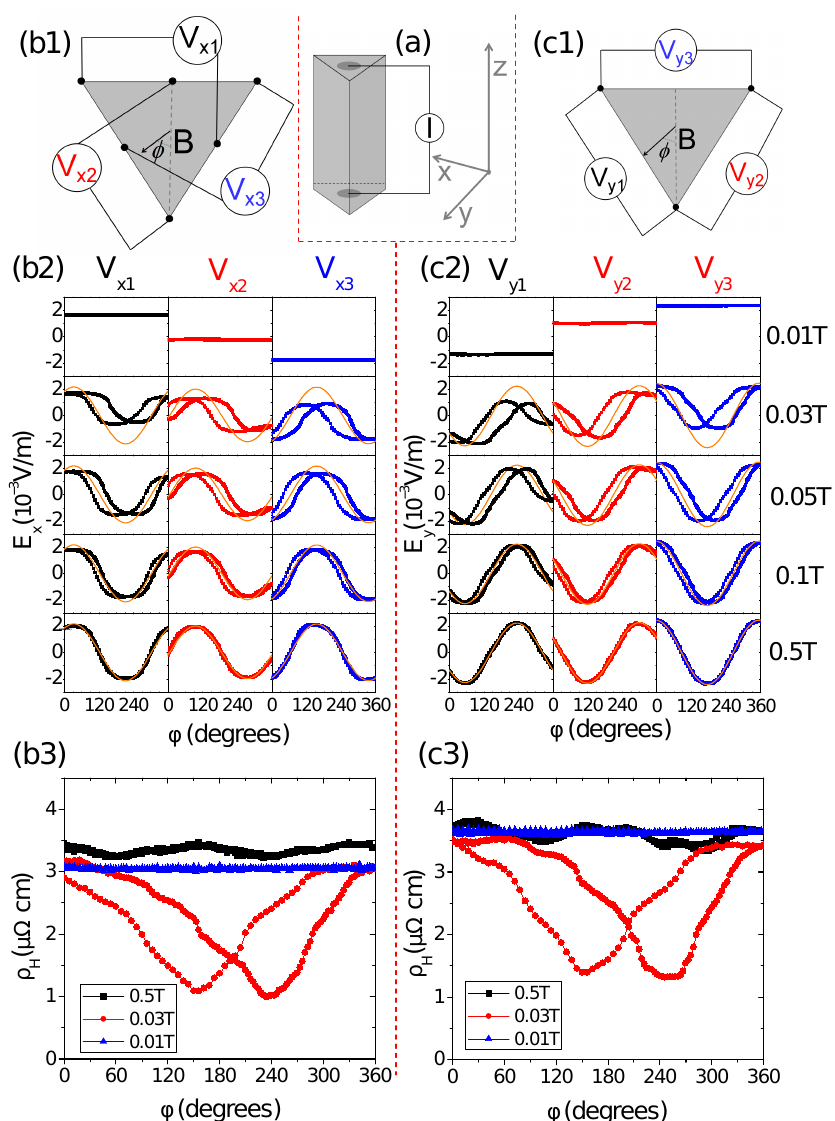
Figure 2: Angle-dependent Hall resistivity: a) The current was applied along the z axis of a sample with a triangular cross section and the magnetic field was rotated in the basal plane. Each pair of electrodes monitored the electric field along one of the three equivalent x axes (b1) or the three y axes (c1). Angular variation of the three E and the three E as a function of the angle between the magnetic field x y and x axis are shown in (b2) and (c2). At low magnetic field (regime I), the total electric field remains unchanged. At high magnetic field (regime III), the measured electric field becomes sinusoidal (shown as a red line). In the intermediate field range (regime II), the electric field is non-sinusoidal and strongly hysteretic. Panels = | E | / J , where | E | represents the magnitude of the total (b3) and (c3) show ρ H electric field vector extracted from its projections. It is almost the same in regimes I and III. The fluctuations in regime III set an upper bound to any in-plane anisotropy undetectable by this